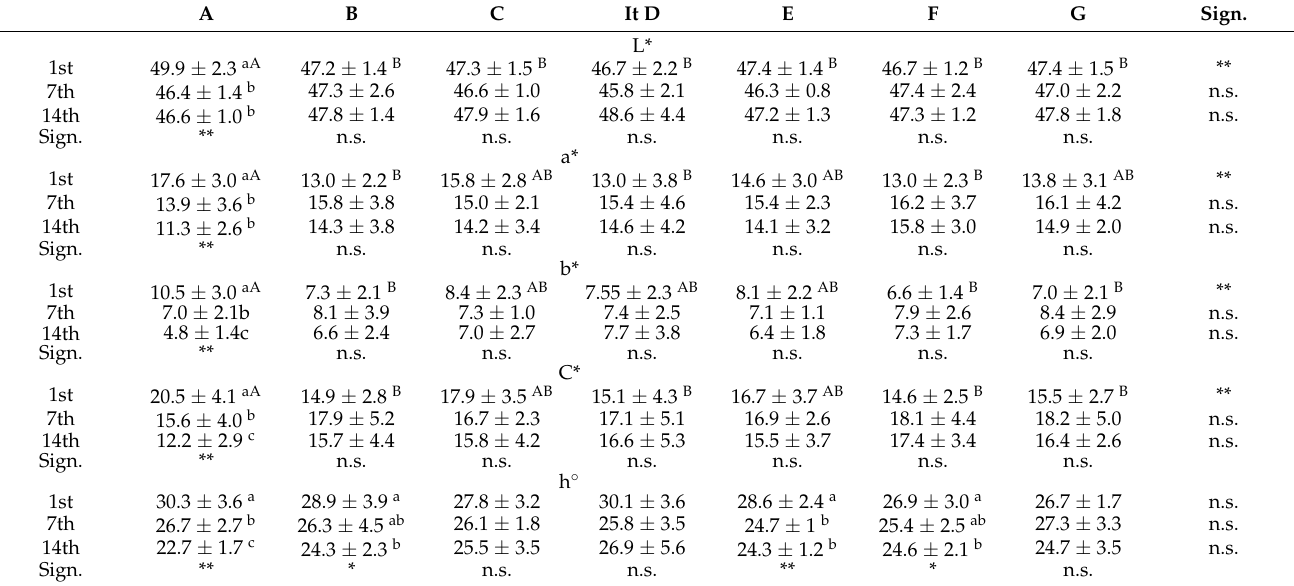
Table 5. Surface color values of minimally treated